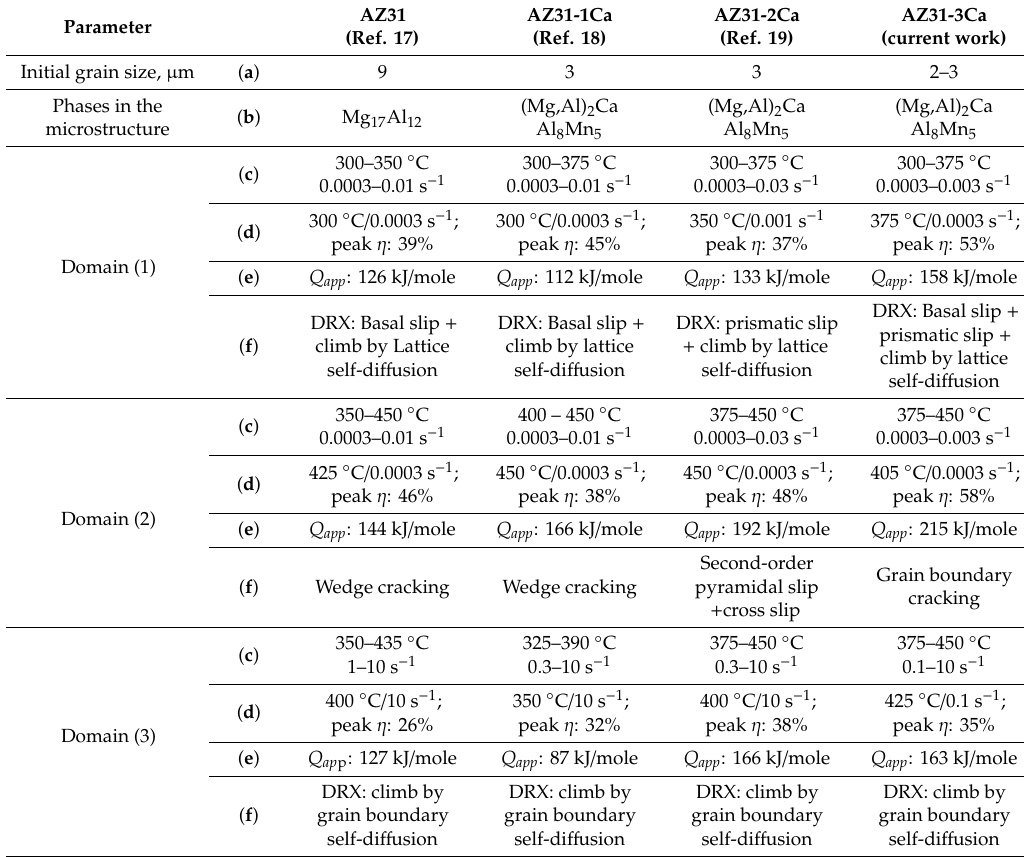
AZ31-1Ca, AZ31-2Ca and AZ31-3Ca magnesium alloys.